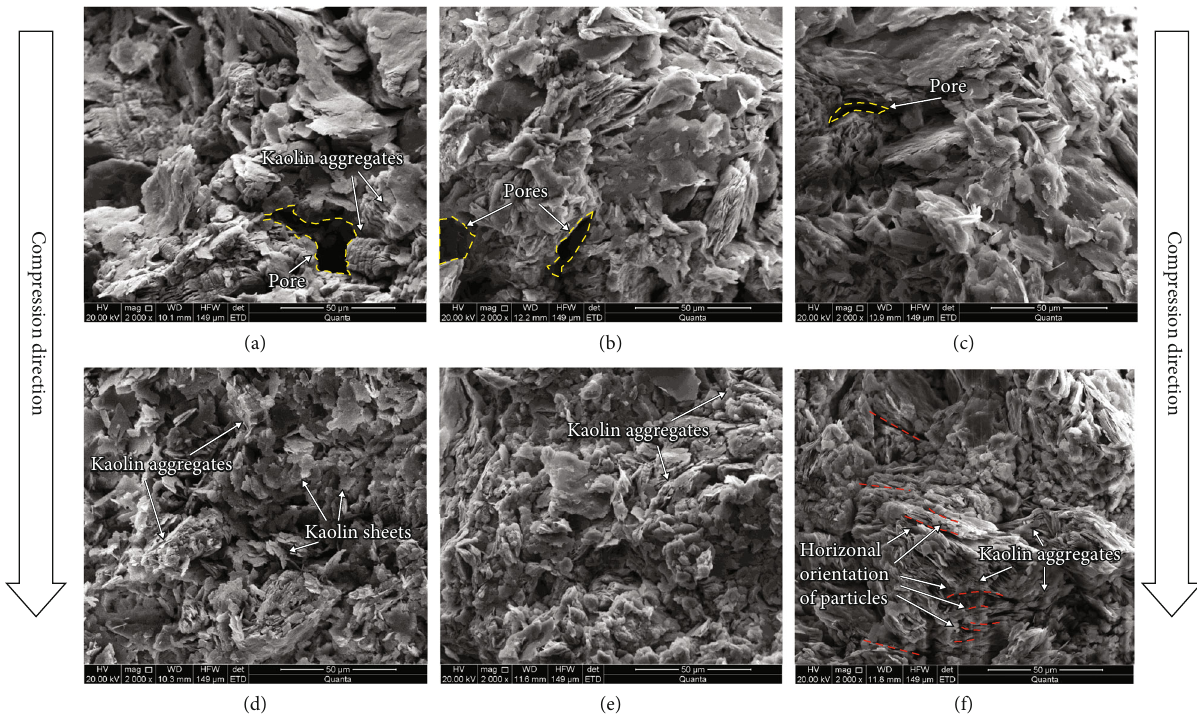
Figure 7: SEM images of di ff erent samples under 2000x magni fi cation: (a) N0; (b) N400; (c) N3200; (d) R0; (e) R400; (f)